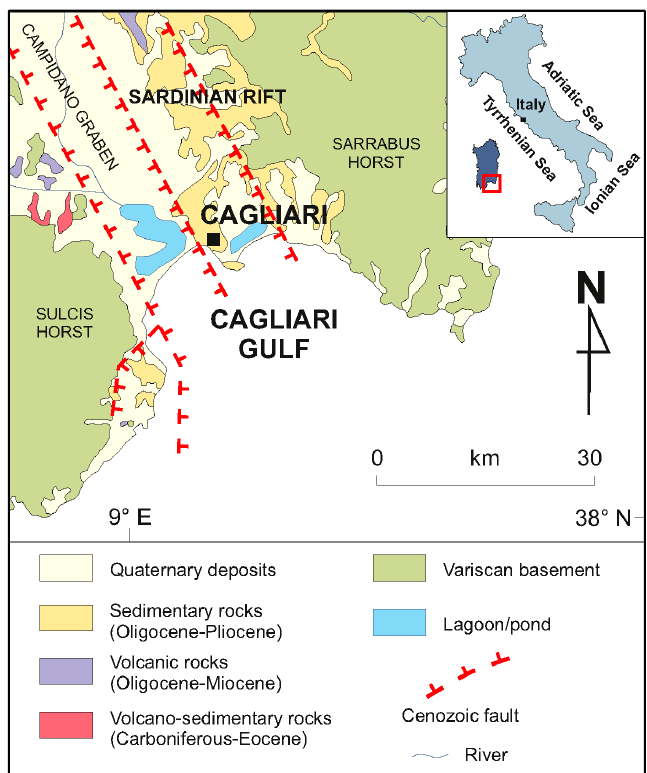
Figure 1. Geological sketch of southern Sardinia